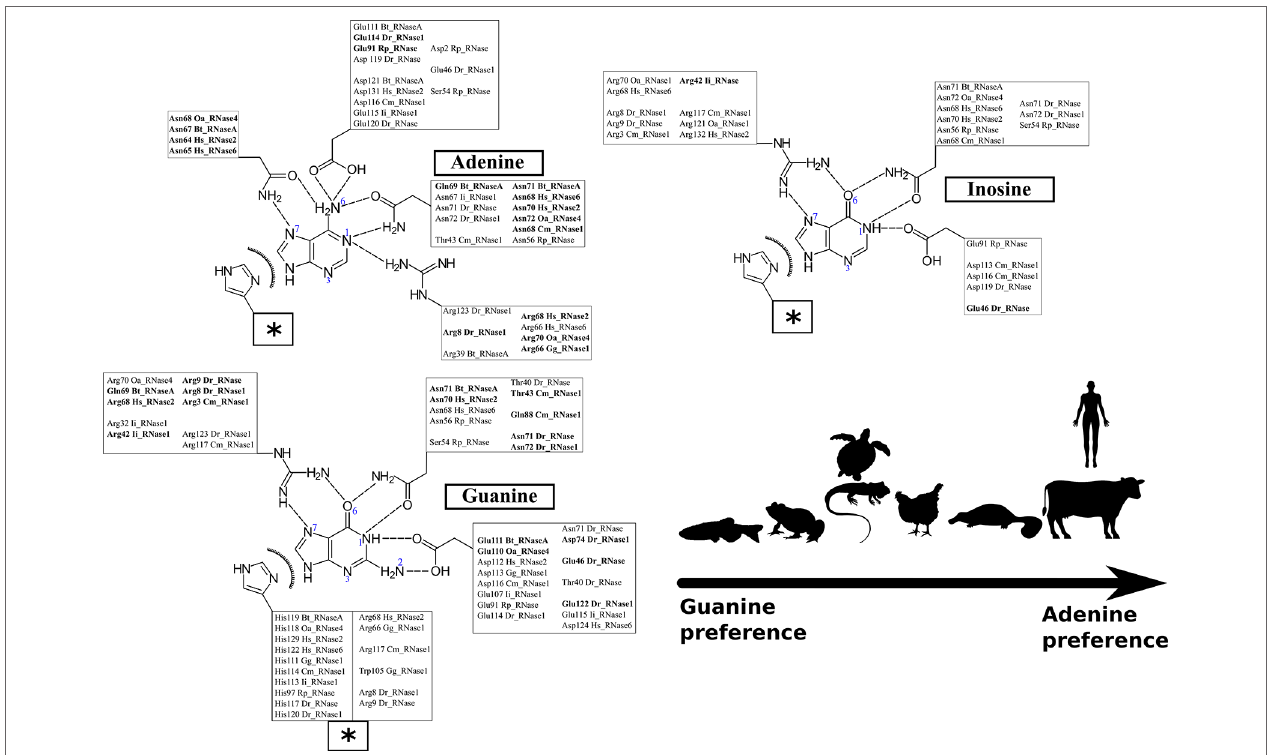
FIGURE 5 | Schematic representation of the predominant interactions observed during the 100 ns of each simulation run. Only the interactions present during more than 30% of the total dynamic runs were considered. The interactions observed in more than 50% of the total dynamic runs are highlighted in bold. Protein residues are listed according to RNase A numbering reference (see Table S2 for structural residues overlapping between the analyzed homologues). Polar and electrostatic interactions are detailed for each location. The box labeled with a star includes the shared common van der Waals interactions for the three base